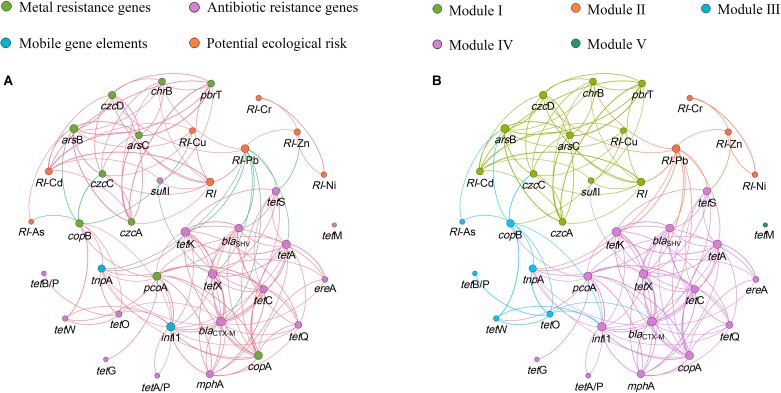
The network analysis showing the co-occurrence patterns among the detected MRGs, ARGs, MGEs and RI. (A) The nodes with different colors represent MRGs, ARGs, MGEs and RI, respectively. The red edges correspond to positive correlations, and the blue edges correspond to negative correlations. (B) The nodes with different colors represent different modularity classes, and the colors of edges correspond to the different modules. A connection stands for a strong (ρ > 0.6) and significant (P < 0.05) correlation. The size of each node is proportional to the number of connections.